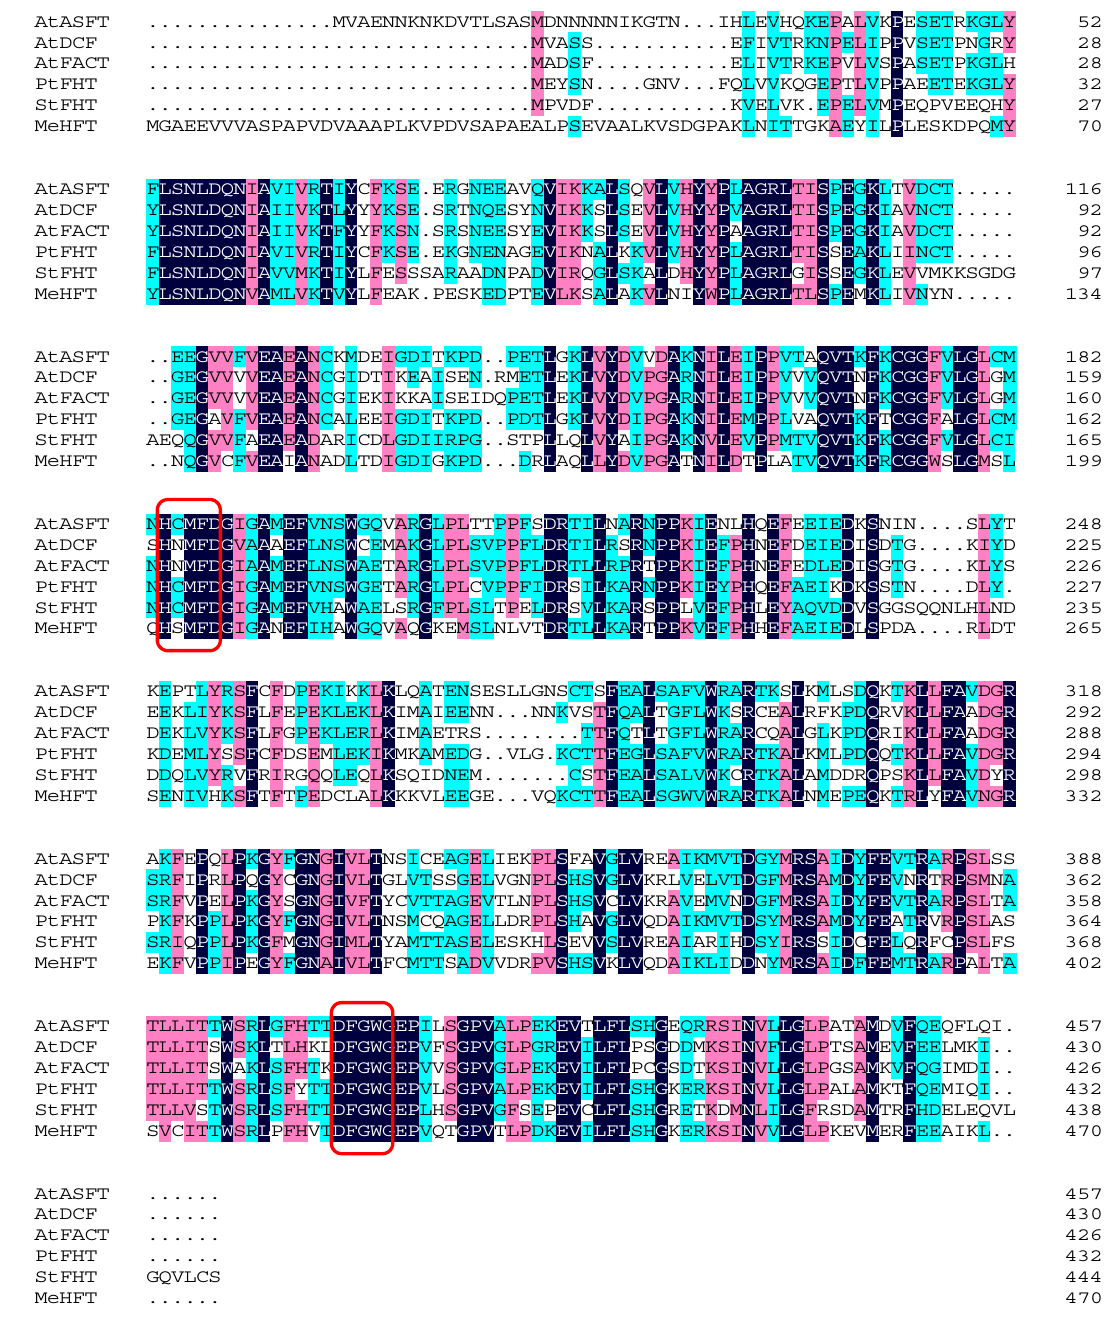
Figure 1. Sequence alignment of MeHFT with PtFHT from P. trichocarpa (JX515962), StFHT from S. tuberosum (ACS70946), AtASFT (AT5G41040), AtDCF (AT3G48720) and AtFACT (AT5G63560) from A. thaliana . The conserved HxxxD and DFGWG motifs are indicated by red boxing.